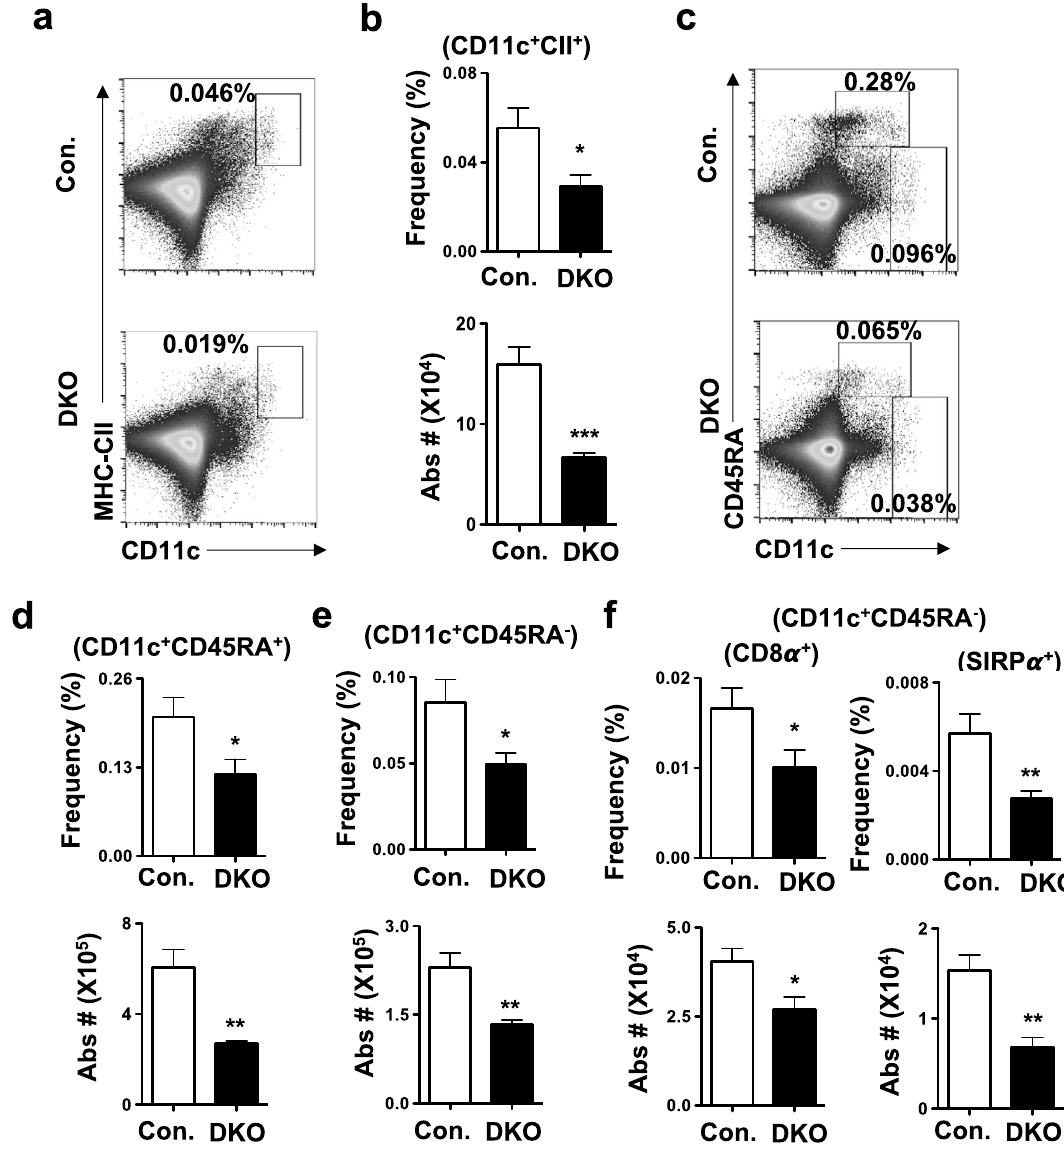
Figure 3. Deficiency of p85 subunits leads to reduced DC numbers in lymphoid organs. ( a ) FACS plots indicating frequencies of CD11c + CII + DCs in the thymus of DKO and control mice. Data are representative of 5 independent experiments. Shown are the frequencies within the indicated gates. ( b ) Frequencies (top) and absolute numbers (bottom) of CD11c + CII + DCs in the thymus of DKO and control mice (n = 8). Indicated are the overall frequencies within the organ. ( c ) FACS plots indicating frequencies of CD11c + CD45RA + pDCs and CD11c + CD45RA − cDCs in the thymus of DKO and control mice. Data are representative of 5 independent experiments. Shown are the frequencies within the indicated gates. ( d ) Frequencies (top) and absolute numbers (bottom) of CD11c + CD45RA + pDCs in the thymus of DKO and control mice (n = 8). Indicated are the overall frequencies within the organ. ( e ) Frequencies (top) and absolute numbers (bottom) of CD11c + CD45RA − pDCs in the thymus of DKO and control mice (n = 8). ( f ) Frequencies (top) and absolute numbers (bottom) of CD8α + (cDC1) (left) and Sirpα + (cDC2) (right) subsets within CD11c + CD45RA − in the thymus of DKO and control mice (n = 8). Indicated are the overall frequencies within the organ. Data represent mean and s.e.m. Two-tailed student’s t tests were used to assess statistical significance (* P < 0.05, ** P < 0.01, *** < 0.001, n.s. P >